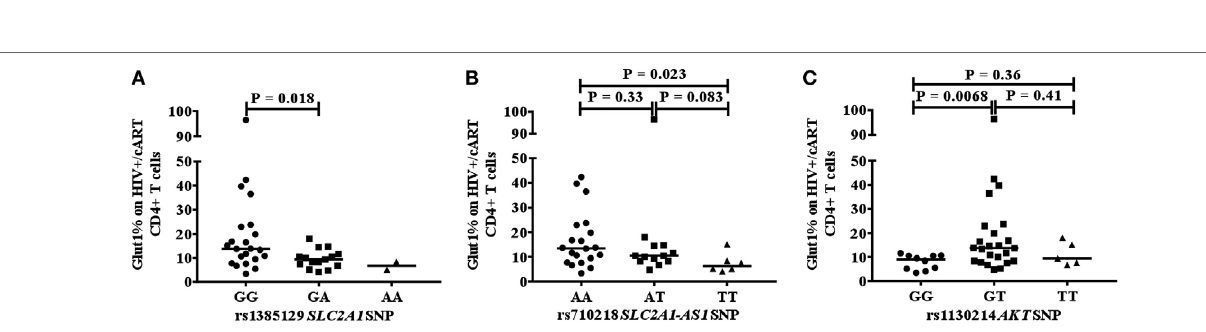
FigUre 2 | CD4 + Glut1 + T cell percentage inversely correlates with CD4 + T cell counts (a,B) , CD4 + T cell percentage (c,D) , and CD4/CD8 ratio (e,F) in HIV-positive individuals confirming previous results (1). cART, combination antiretroviral